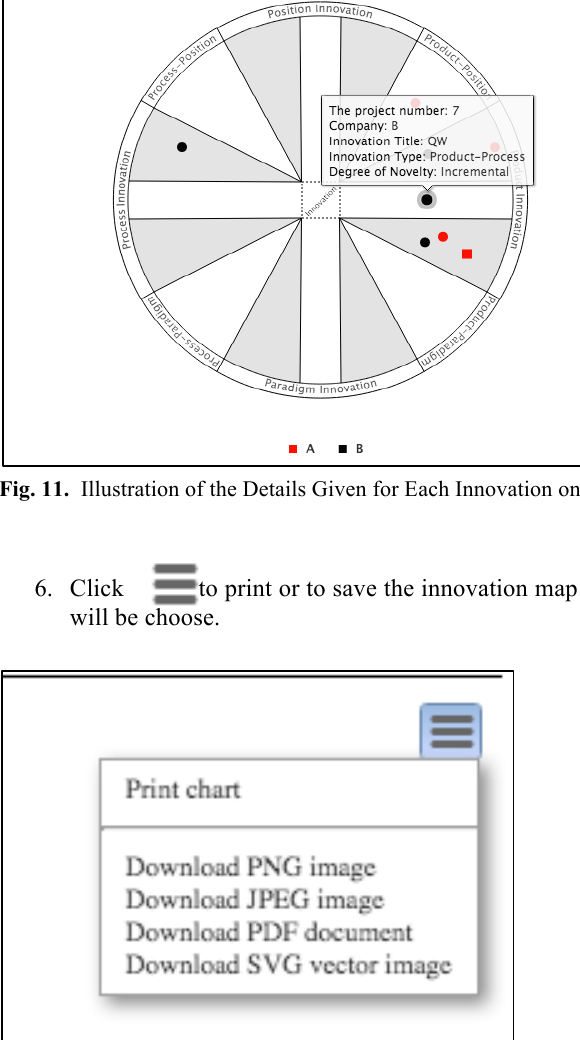
Fig. 12. Options for Saving and Printing 7. To modify innovation data click “Edit”, and to delete it click “Delete”. 8. To show the database of innovation click “Chart List”, then choose the